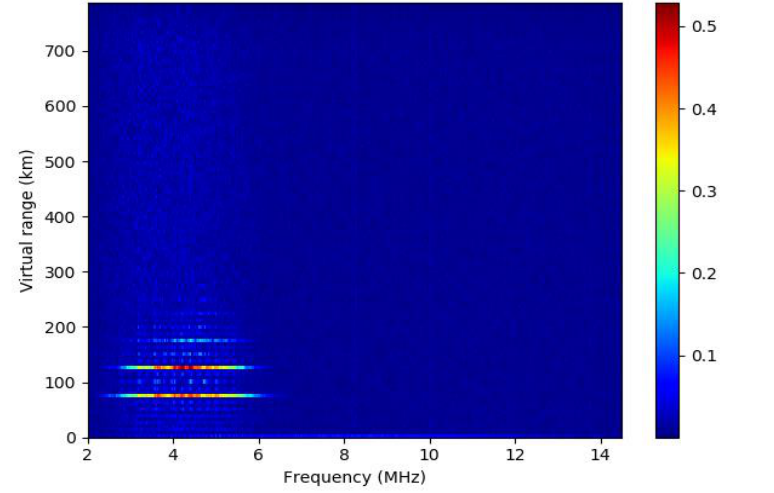
Fig. 8. Ionogram recorded in the laboratory experiments by the OFDM ionosonde. Ionogram exhibits 2 modes that correspond to reflections of radio waves from different ionosphere layers. Frequencies of observed echoes were limited by the delay line